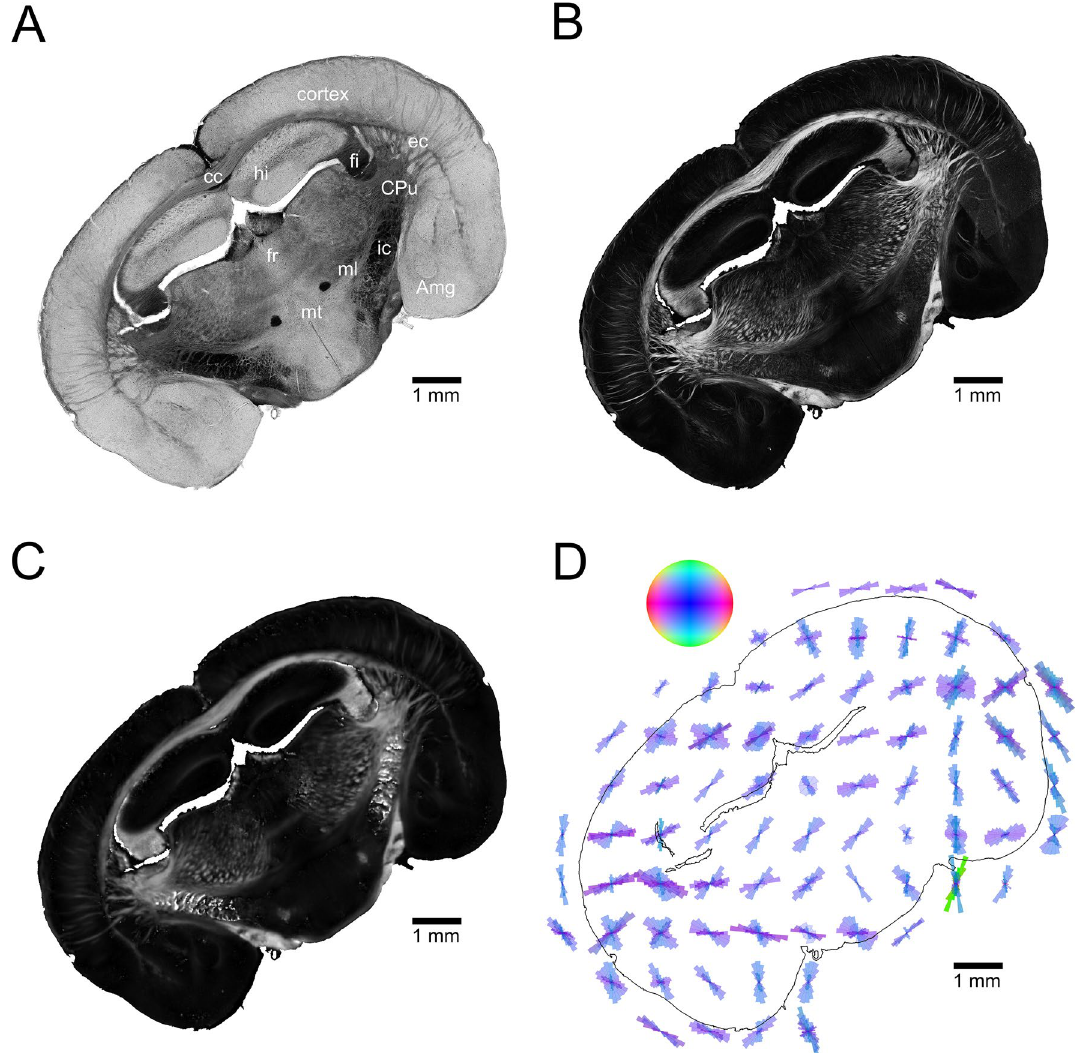
Figure 5. Different modalities of the brain section as obtained from the 3D-PLI microscopy measurement. ( A ) Normalized transmittance image. ( B ) Retardation image. ( C ) Relative thickness map, representing the myelin density. ( D ) Top down view of the spherical 3D-histograms of the vector data with a spatial resolution of 1 mm × 1 mm as obtained by gathering each mm 2 tile (769 × 769 vector objects) of the high resolution (1.3 μm) 3D-PLI vector array into a single histogram (cf. Fig. 1). The peripheral line (white) is the contour line of the registered brain section. The color of the 3D-histograms corresponds to the color code shown at the top distribution in dark-field map (η) means that SANS patterns has significantly low scattering in Porod regime (at low- q ). Moreover, Σ and Π are flanked by steep fiber bundles clearly visible in transmittance map of ‘fi’, and even reflected perfectly by the Bragg peak azimuths in the vicinity, which are good candidates for absorbing neutrons at small scattering angles. The β-region (yellow lines) of the dark-field map covers the extended Σ-region of the MBPI map. These regions correspond to ‘Amg’, ‘opt’ and ‘ic’. It shows a distribution of scattering intensity of intermediate range in dark-field (yellow lines) as well as in MBPI map (yellow lines). This region is confined medially by steep fibers of the internal capsule (dark retardation and dark transmittance) and laterally by transversal fibers of the optic tract (bright retardation and dark transmittance). The fiber direction of these two tracts is reasonably reflected by the directions of the SANS patterns. The transversal prevalence of the fiber directions due to the vertical arrange- ment of the Bragg peak azimuths in the left hemisphere on the left side might be due to flat tracts penetrating the much steeper internal capsule from medial to lateral. The γ, α-regions (red lines at the top and the bottom, respectively) and their interconnection in the dark- field corresponds to upper, lower and middle portion of Δ-region (yellow lines) of the MBPI map. These regions cover the entire central portion of the section. These regions exhibit high scattering intensity in dark-field and overall low to intermediate intensity in MBPI map. Here, a discrepancy between the SANS scattering modali- ties is visible along the interhemispheric fissure. While MBPI is maximal in the center directly below the third